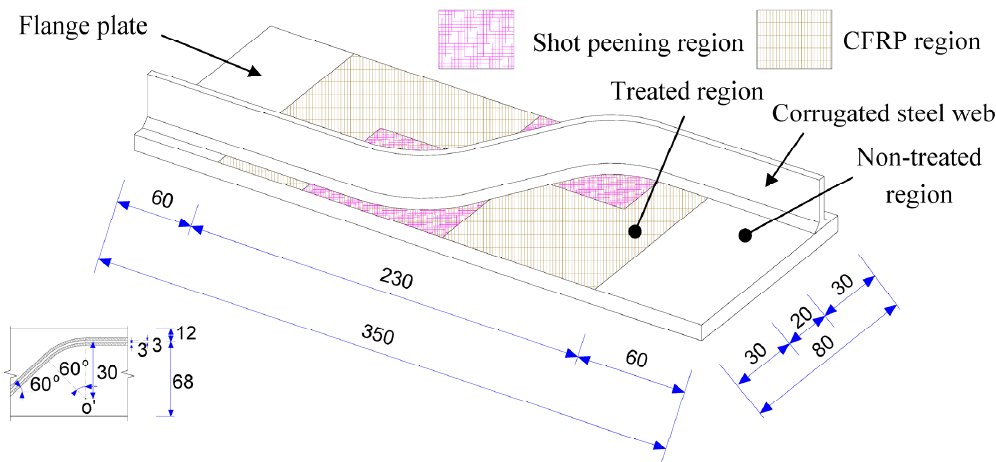
Figure 1. Geometry of a typical test specimen.